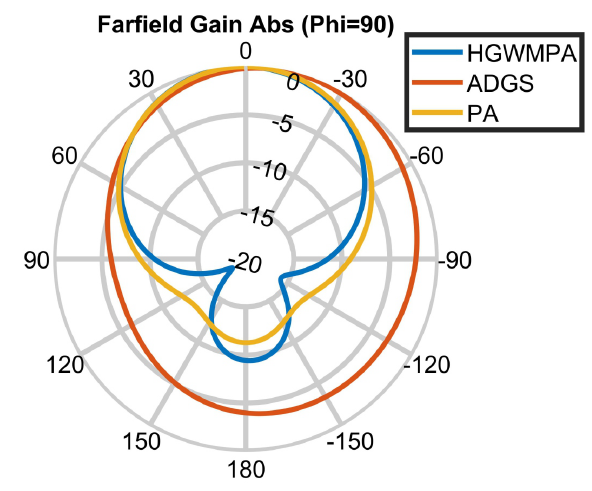
FIGURE 6. Normalized radiation patterns of the PA, ADGS and HGWMPA at 4.8 GHz (Phi=90 deg. plane).